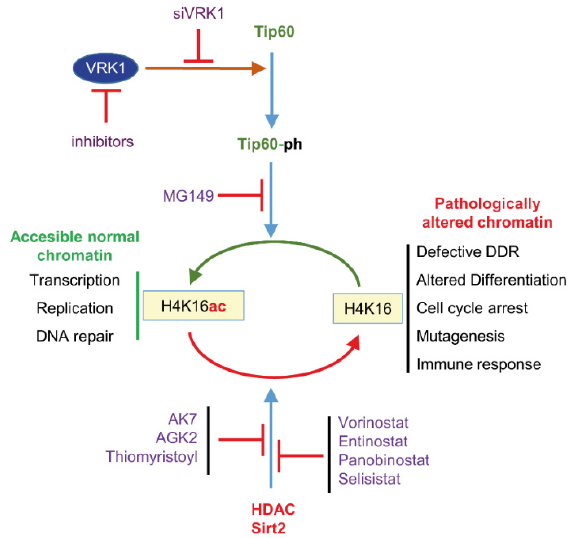
Figure 4. Effect of epigenetic inhibitors on H4K16 acetylation and deacetylation that modulate chromatin relaxation associated with different roles in transcription, replication and DNA damage, some of which are local o gene specific, and others affect chromosomes more globally. Therefore, there is a very large number of potential combinations that need to be identified and tested in specific tumor types or stages.